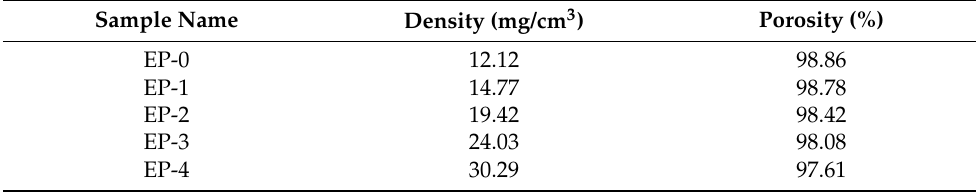
Figure 2. SEM images of PANI nanorods. ( a ) EVOH/PANI composite NFAs; ( b – f ) EP-0, EP-1, EP-2, EP-3 and EP-4. Table 2. The density and porosity of EVOH/PANI composite